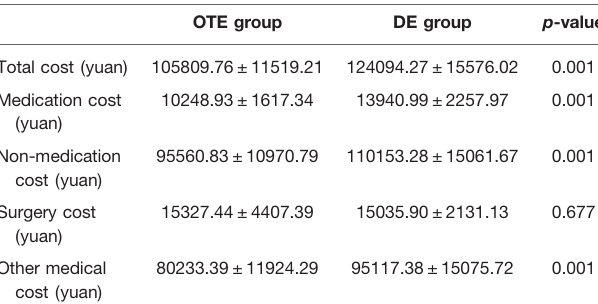
TABLE 4 | Cost analysis of different extubation